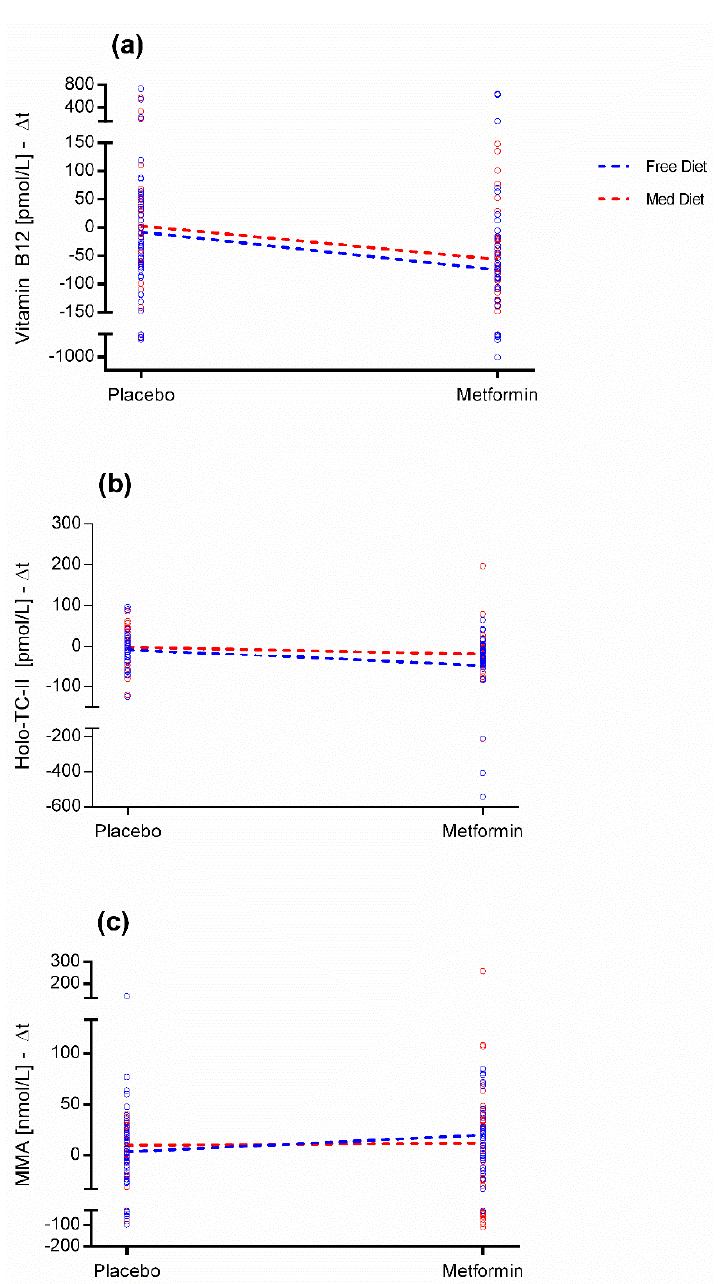
Figure 1. Interaction plots. Each graph depict the ANOVA results on ( a ) B 12 , ( b ) Holo-transcobalamin-II (Holo-TC-II), and ( c ) Methylmalonic acid (MMA). They show the average response variable (i.e., absolute differences between baseline and after three years on the y -axis, Δ t = T1–T0) in relation to the treatment level (on the x -axis) for each level of diet. Each dot represents the individual difference between baseline and the three years levels of each considered variable.